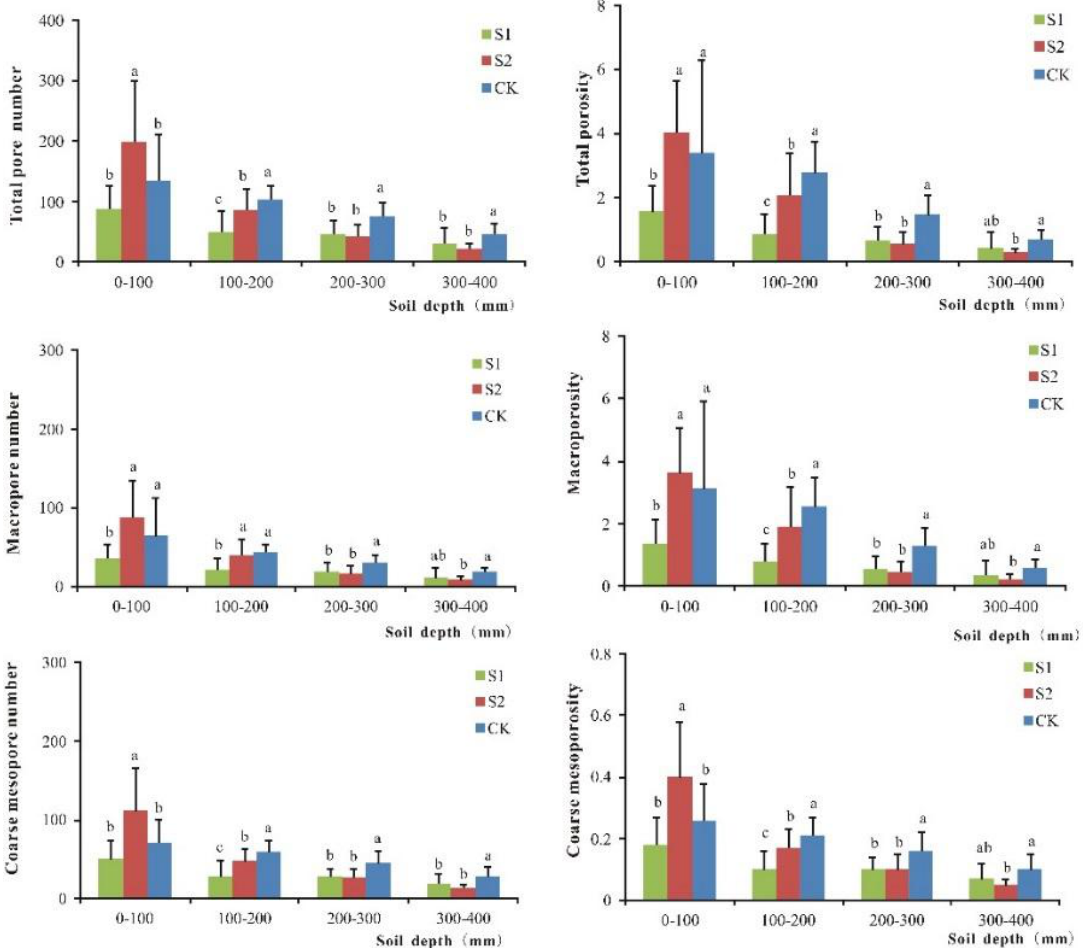
Figure 2. One-way analysis of variance of total pore number, total porosity, macropore number, macroporosity, coarse mesopore number, and coarse mesoporosity under S1 (irrigated with sewage for 25 years, 3 replicates), S2 (irrigated with sewage for 52 years, 3 replicates), and CK (irrigated with groundwater, 3 replicates).